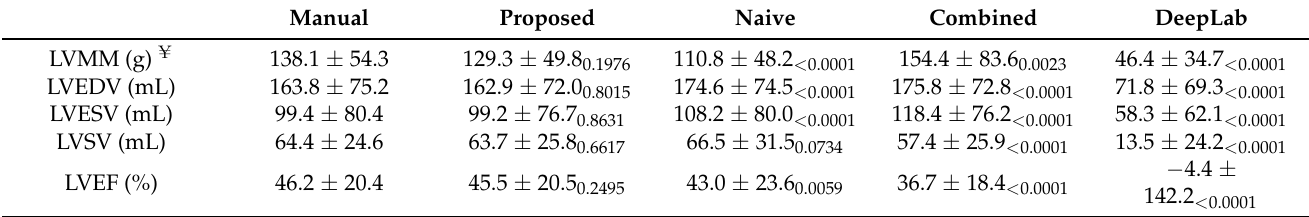
Table 2. Algorithm and manual LV function measurements (mean ± SD) for n = 180 images from 90 previously unseen ACDC test